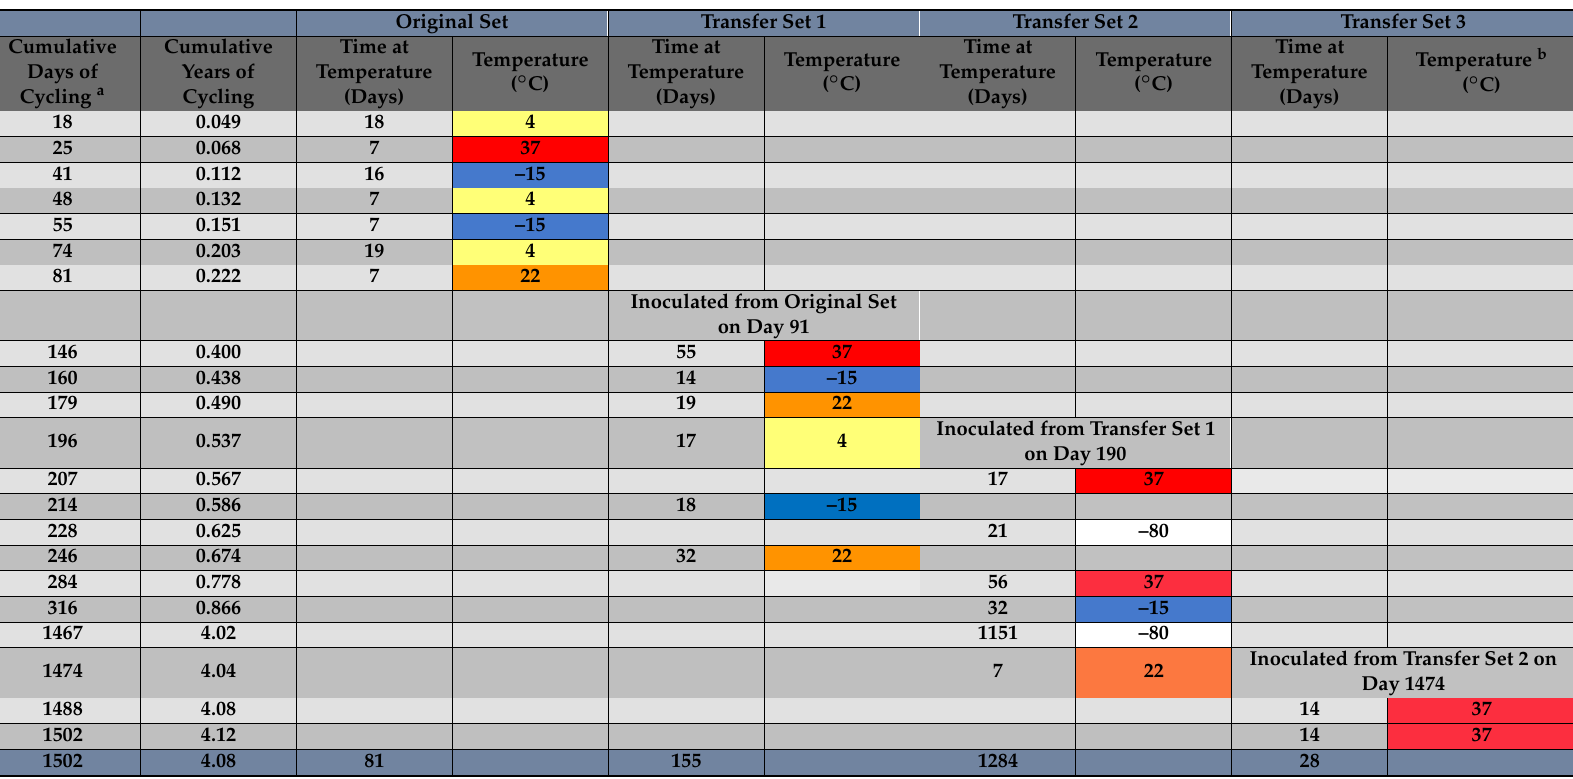
Colors correspond to temperature of cycle: Incubation temperature (red, 37 ◦ C), room temperature (orange, 22 ◦ C), 4 ◦ C (yellow), − 15 ◦ C (blue), − 80 ◦ C (white). Original set tubes were re-pressurized with 2 bar H 2 on Day 74 during cycling. a Cumulative Days of Cycling correspond to the number of days elapsed since the Original Set was first inoculated; b Instances where temperatures are identical for two adjacent cycles indicate that the cultures were removed from incubation, tested for methane production, and replaced at that temperature for an additional incubation